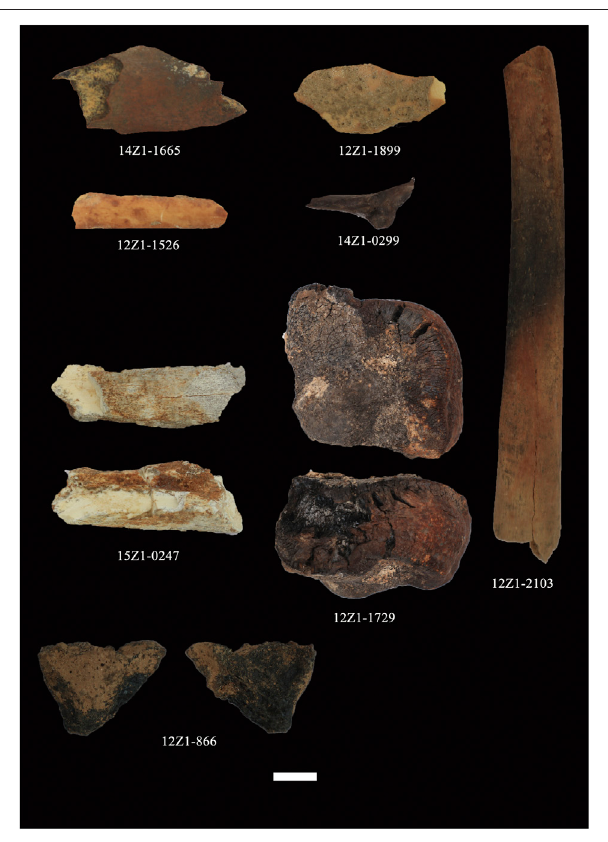
FIGURE4| Appearance ofbonesampleswithCIvalues > 0.3,indicating the samples were heated to 600 ° C or above.